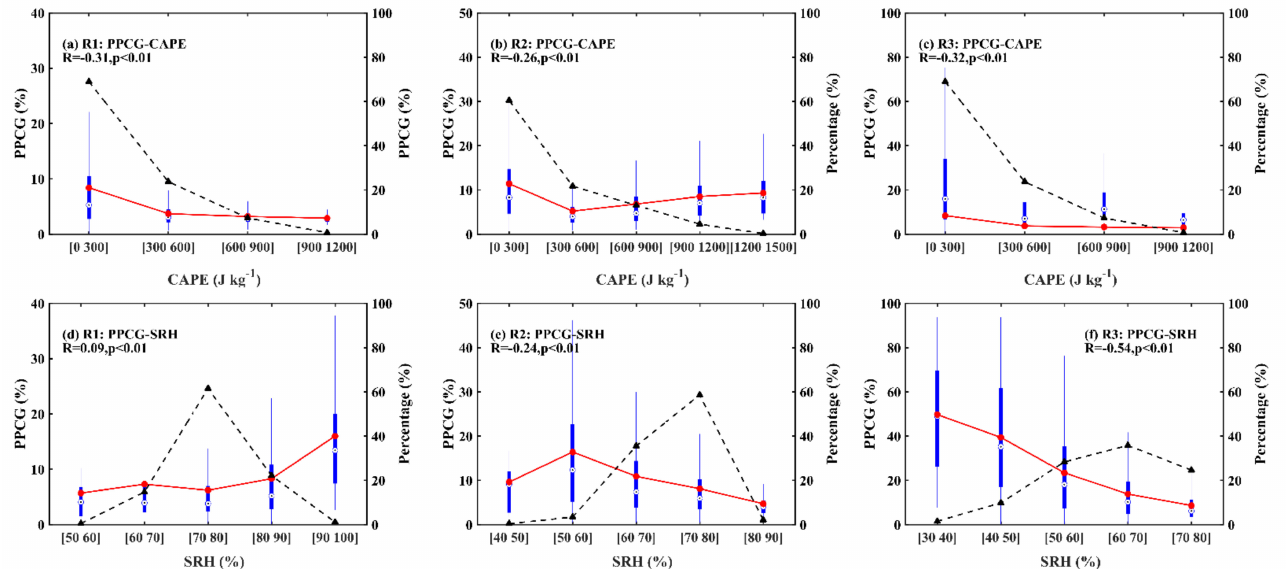
Figure 7. Box plots of PPCG dispersion showing the relationship between the PPCG and two thermodynamic factors (derived from ERA5): ( a )~( c ) CAPE and ( d )~( f ) SRH over the three study regions during 2010–2018. Box plots represent the 25th to 75th percentile of the data in this box (the distance between the bottom and the top of the box), the median (the white circle in each box), the maximum (the end of the whisker above), and the minimum (the end of the whisker below). The red dot in each box represents the mean. The black dot represents the percentage of data points in each bin of CAPE or SRH to the total data point. The Pearson correlation coefficients (R) and p values are also presented in each panel. Data from all seasons are